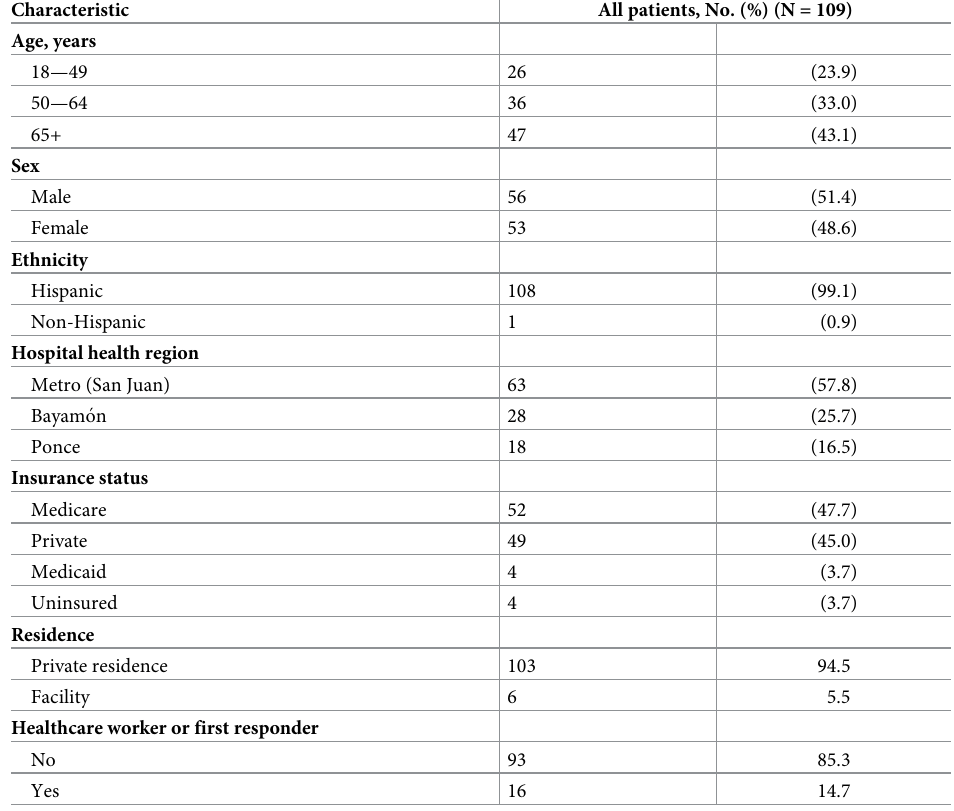
Table 1. Demographic characteristics of adults hospitalized with COVID-19 (N = 109), Puerto Rico, March- August